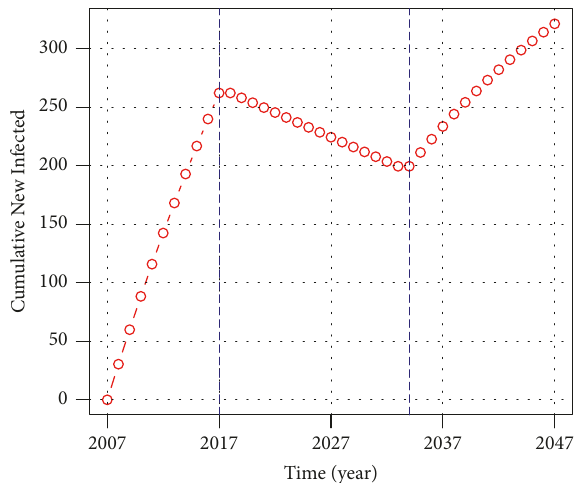
Figure8:Theresultofsimulationofinterruptedcontrol.Parameters associated with control strategies were 𝑑 = 25 % (detection of infected people), 𝜌 = 80 % (treatment of infected newborn), and 𝜉 = 80 % (effectiveness on surveillance in blood transfusion). The control strategies were applied after 10 years of simulation. After 15 years of application, the control strategies were stopped.